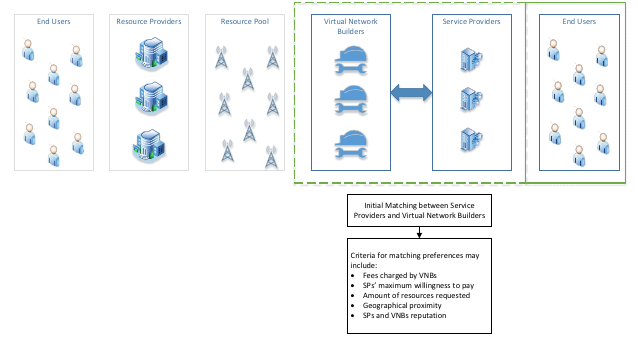
needs to obtain an appropriate bundle of resources from the pool. These resources correspond to the aggregate demand of all the partners of a given VNB.